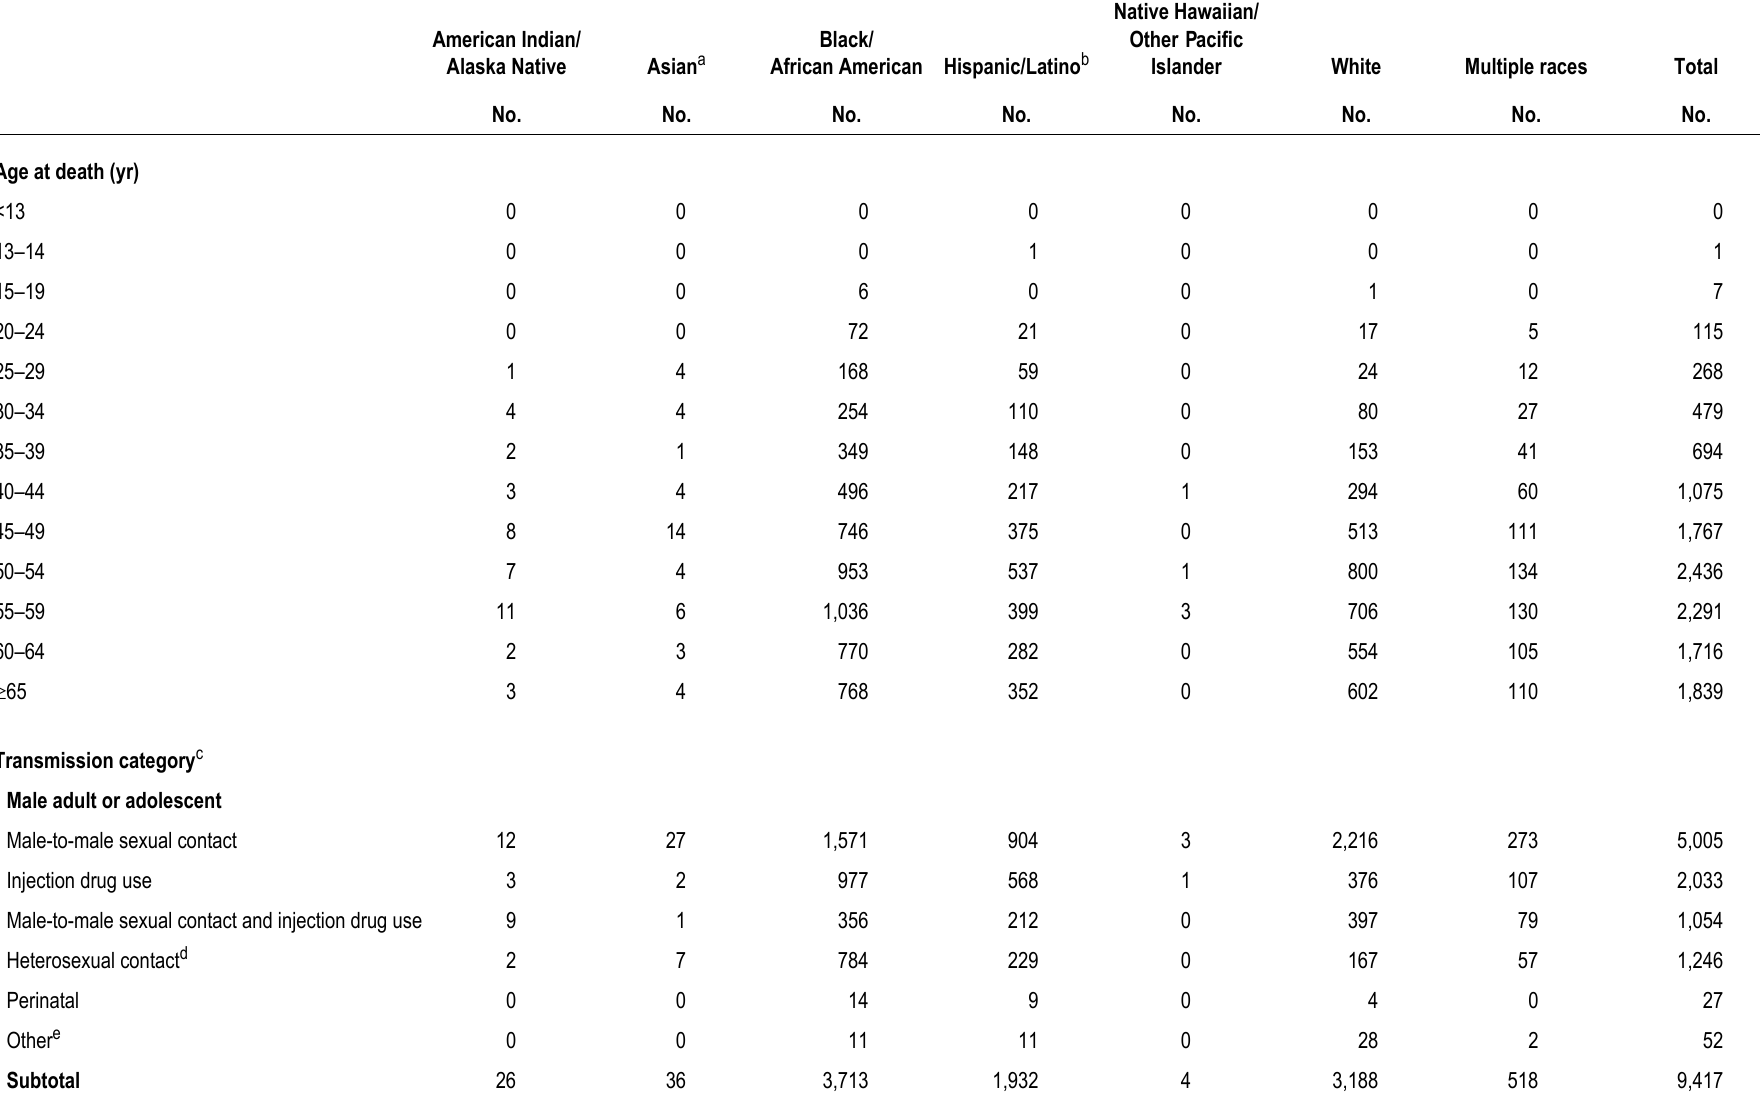
Table 15b. Deaths of persons with diagnosed HIV infection ever classified as stage 3 (AIDS), by race/ethnicity and selected characteristics, 2014—United States and 6 dependent areas